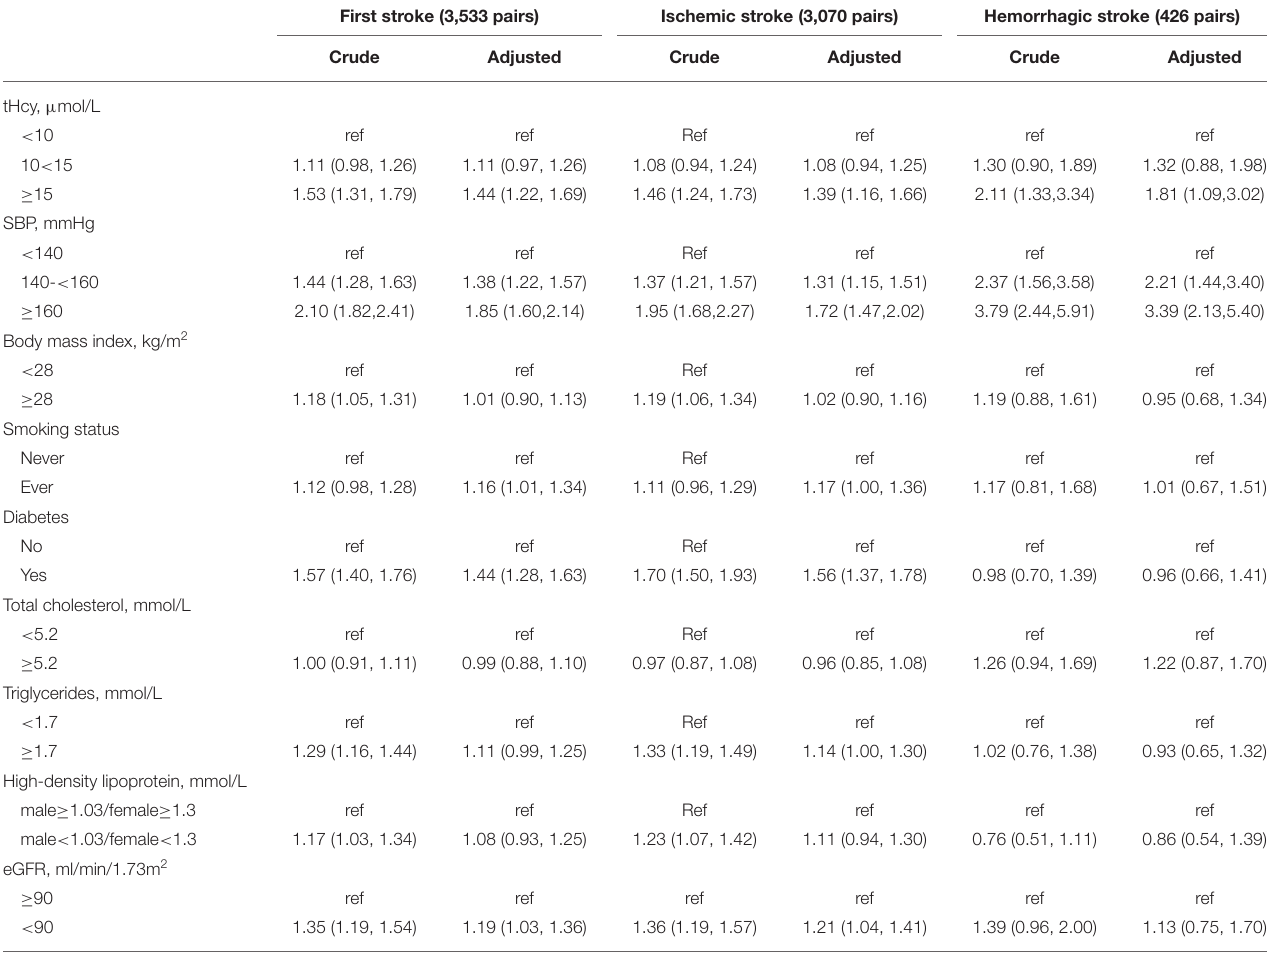
TABLE 2 | The associations of tHcy and traditional risk factors with the risk of first stroke, ischemic, and hemorrhagic stroke. First stroke (3,533 pairs) Ischemic stroke (3,070 pairs) Hemorrhagic stroke (426 pairs) Crude Adjusted Crude Adjusted